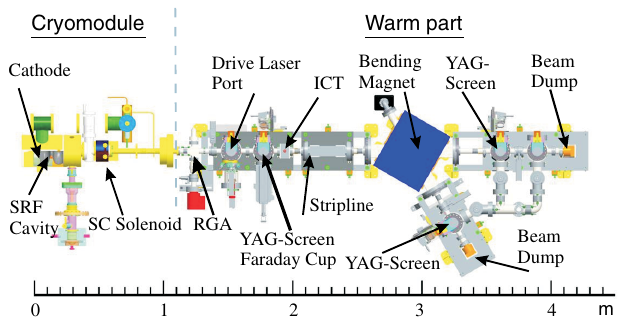
FIG. 2. Schematic view of the cold system and the beam